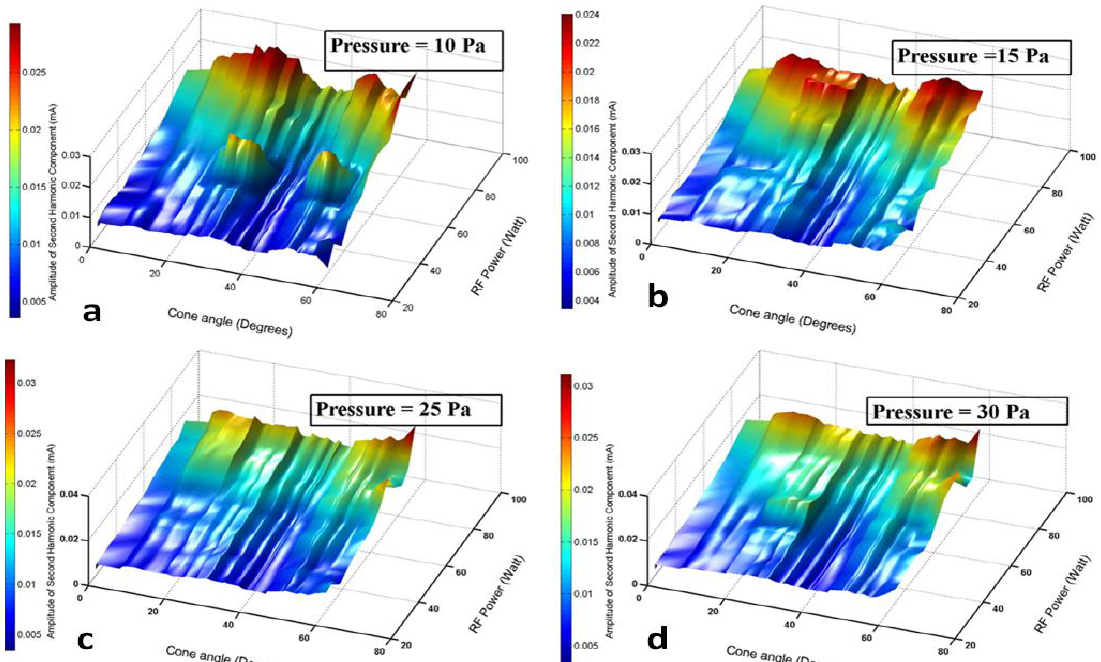
Fig.5: The second harmonic component plotted against and RF power for four pressure values. a: 10 Pa, b: 15 Pa, c: 25 Pa, d: 30 Pa